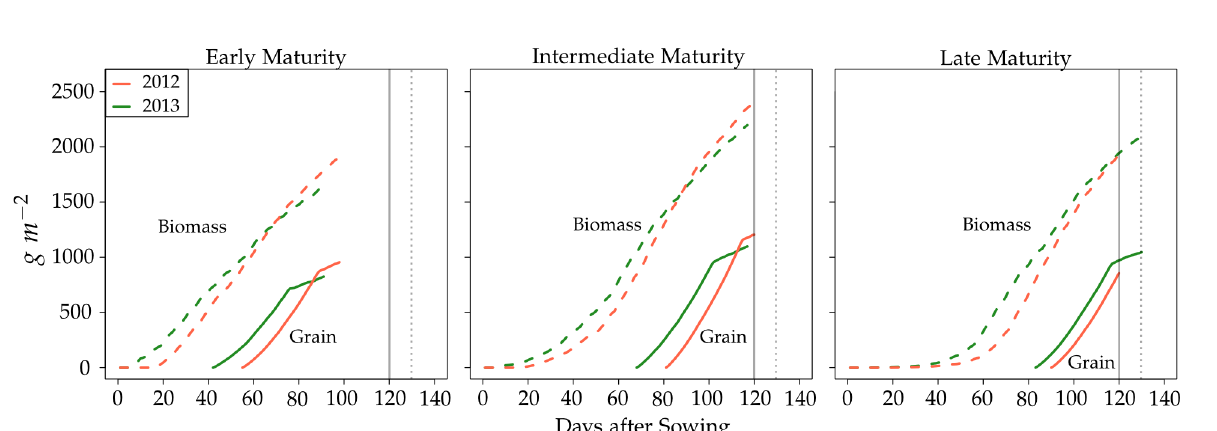
Fig 2. Simulated development of total biomass and grain yield. The early, intermediate and late maturing genotypes had a total leaf number (TLN) of 6, 14.5 and 23, respectively. The values for the other three traits were 750 for AM, 1.6 for SRE and 1150 for MTU and in common for all genotypes. The full and dotted vertical lines indicate the end of the 2012 and 2013 growing season,